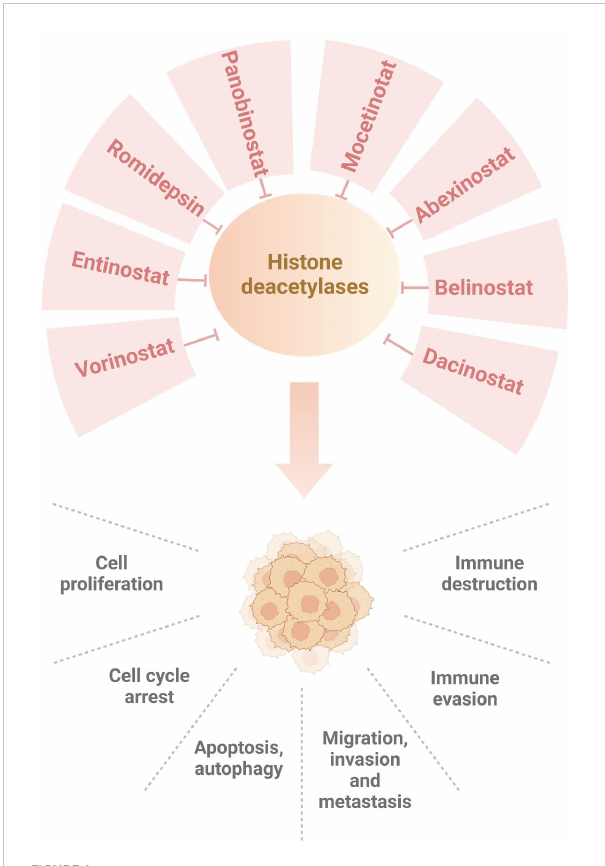
FIGURE 1 Numerous HDAC inhibitors suppress histone deacetylases in breast cancer. Dacinostat, belinostat, abexinostat, mocetinotat, panobinostat, romidepsin, entinostat and vorinostat, inhibit histone deacetylases and regulate breast tumorigenesis, progression and